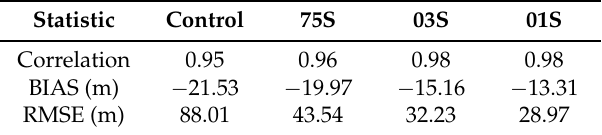
Table 3. Statistics of model height for the inner domain compared with AWS stations.